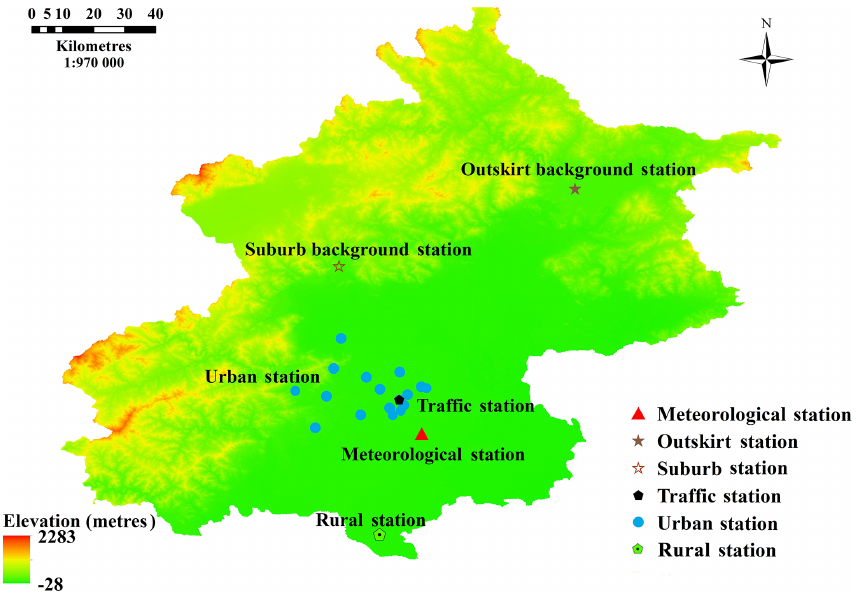
Figure 1. Locations of different ground monitoring stations. Table 1. The comparison of local environmental statistical data used for this research and other official statistical data in 2017 (unit: 10kt). BC: black carbon; OC: organic